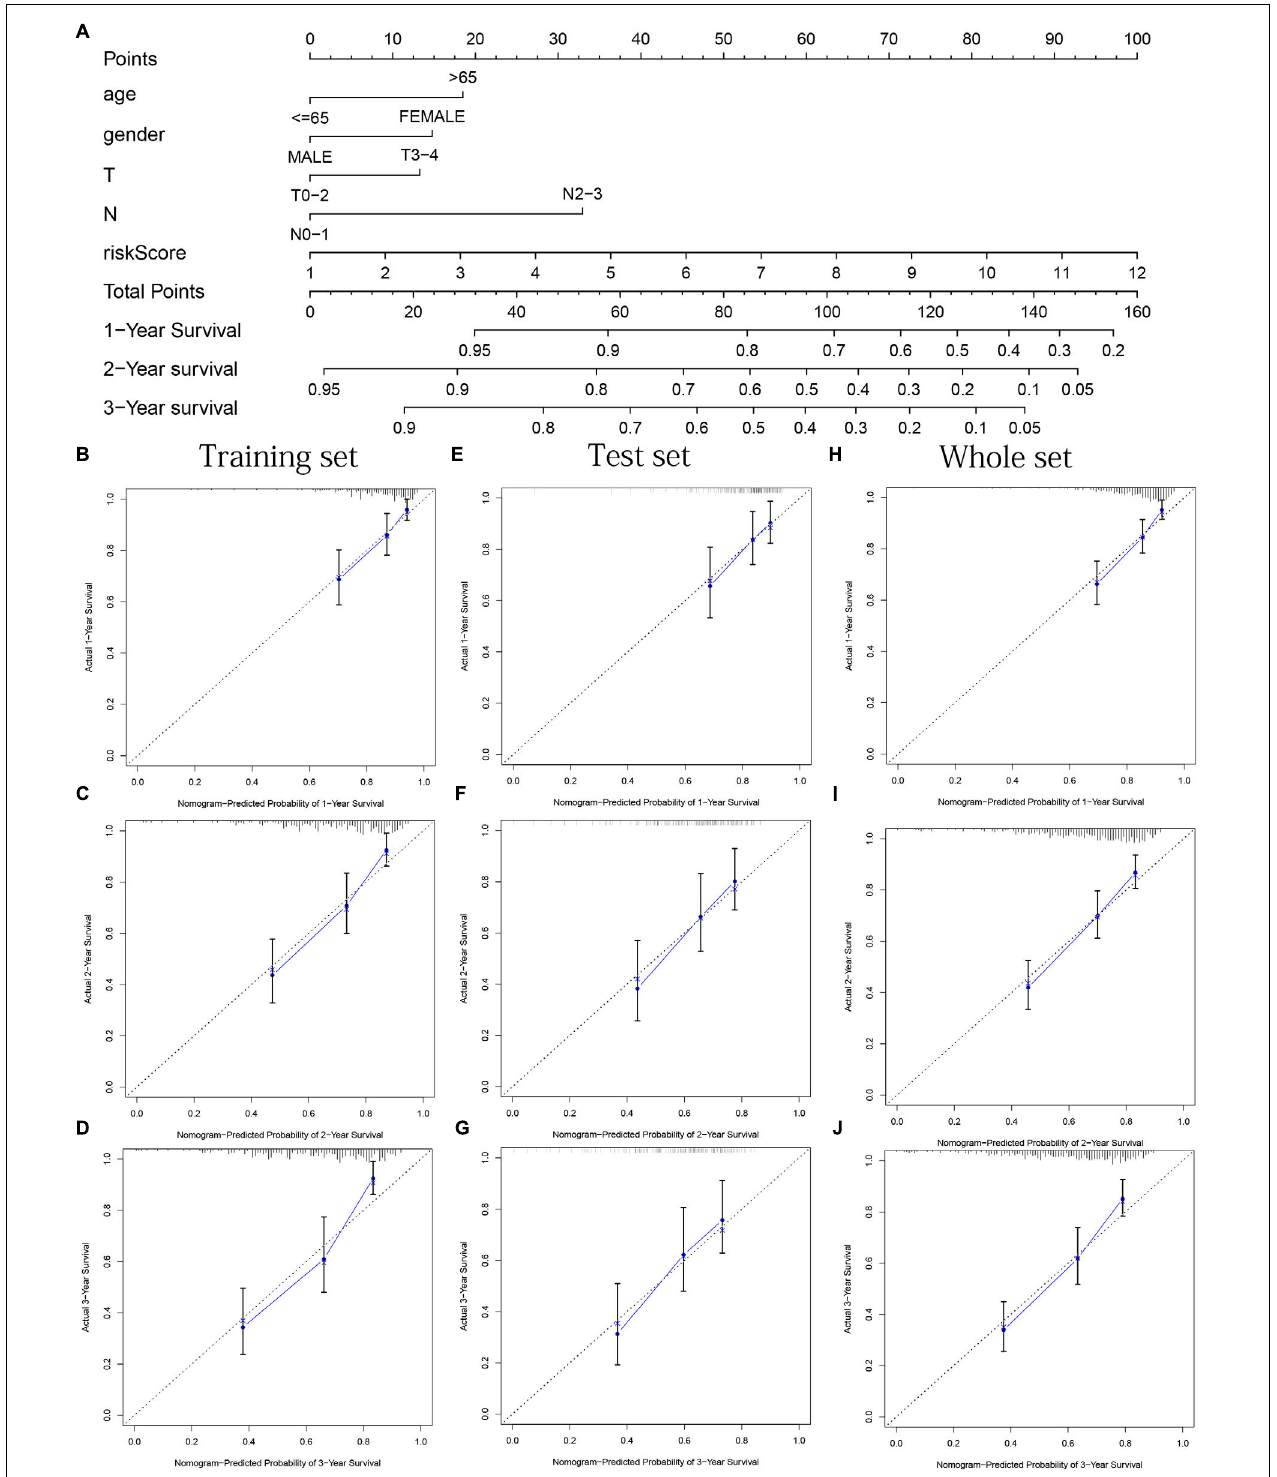
FIGURE 11 | Nomogram based on prognostic model accurately predicts the OS of HNSCC patients. (A) The nomogram composed of various clinical risk factors and risk scores predicts the 1-, 2-, and 3-year survival probability of HNSCC patients. (B–D) One, 2, and 3 years internal calibration curve of the training set, respectively. (E–G) One, 2, and 3 years internal calibration curve of the test set, respectively. (H–J) One, 2, and 3 years internal calibration curve of the whole set, respectively.